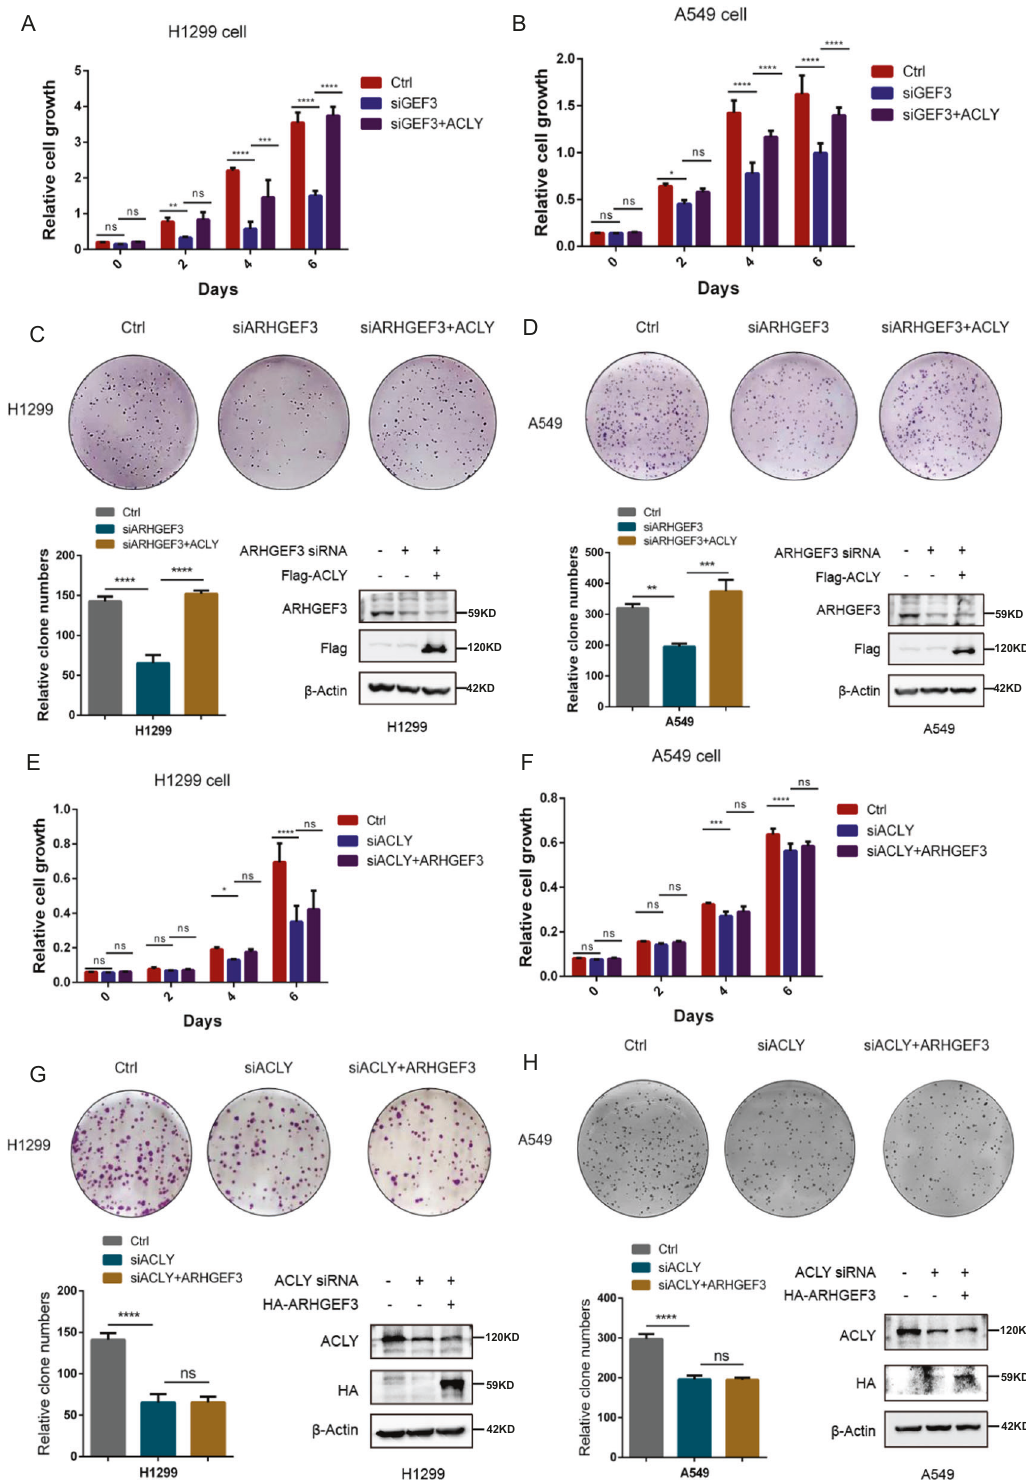
Fig. 7 ARHGEF3 promotes NSCLC cell proliferation by regulating ACLY. A , B The effects of ACLY on the growth of H1299 and A549 cells after ARHGEF3 knockdown was detected by cell count assays. The results represent the average of three independently repeated experiments (mean ± SD), ns no signi fi cance, * P < 0.05, ** P < 0.01, *** P < 0.001, **** P < 0.0001. C , D The effects of ACLY on the proliferation of H1299 and A549 cells after ARHGEF3 knockdown were detected by clonal colony formation assays (upper panel). Statistical analysis between groups (bottom panel), the results represent the average of three independently repeated experiments (mean ± SD), ** P < 0.01, *** P < 0.001, **** P < 0.0001. E , F The effects of ARHGEF3 on the growth of H1299 and A549 cells after ACLY knockdown was detected by cell count assays. The results represent the average of three independently repeated experiments (mean ± SD), ns no signi fi cance, * P < 0.05, *** P < 0.001, **** P < 0.0001. G , H The effects of ARHGEF3 on the proliferation of H1299 and A549 cells after ACLY knockdown were detected by clonal colony formation assays (upper panel). Statistical analysis between groups (bottom panel), the results represent the average of three independently repeated experiments (mean ± SD), ns no signi fi cance, **** P < 0.0001. Cell Death and Disease (2022)